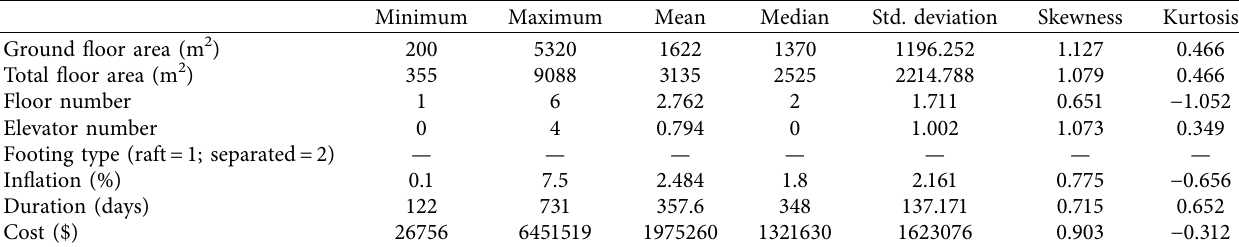
Table 1: Descriptive measures of the cost data for the training